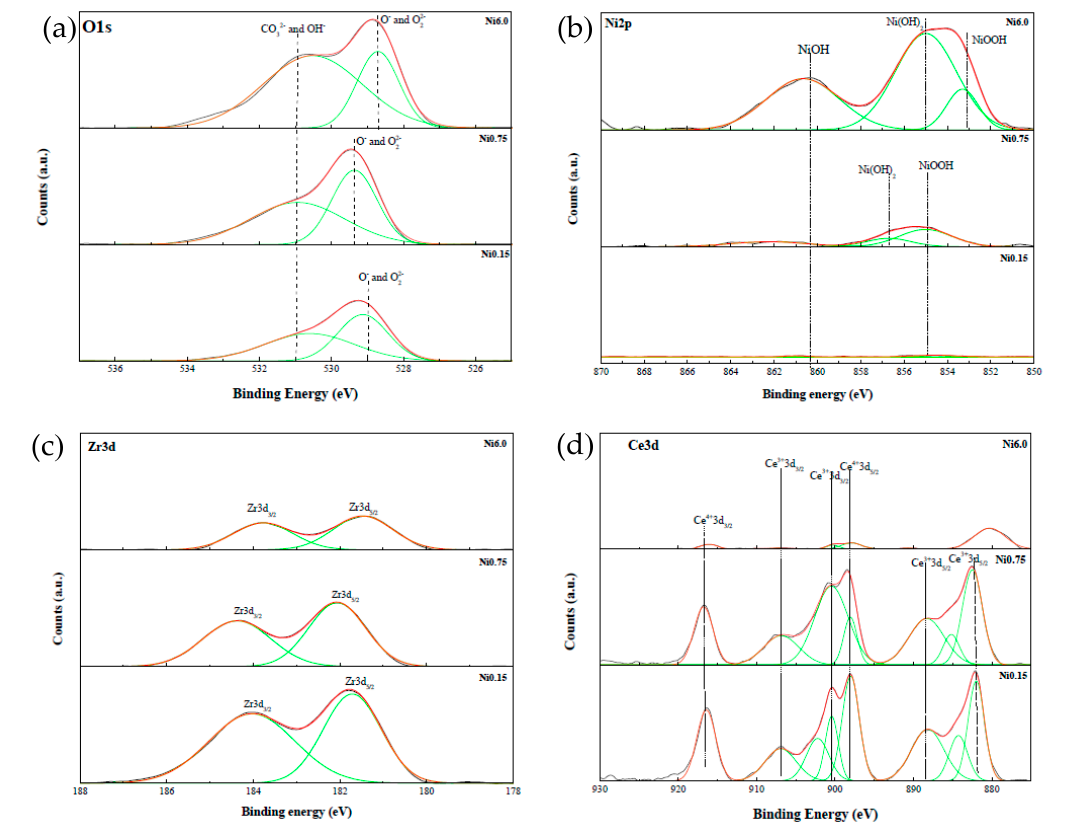
Figure 4. XPS spectra of Ni-Ce-ZrO δ catalysts; ( a ) O1s, ( b ) Ni2p, ( c ) Zr3d, and ( d ) Ce3d.